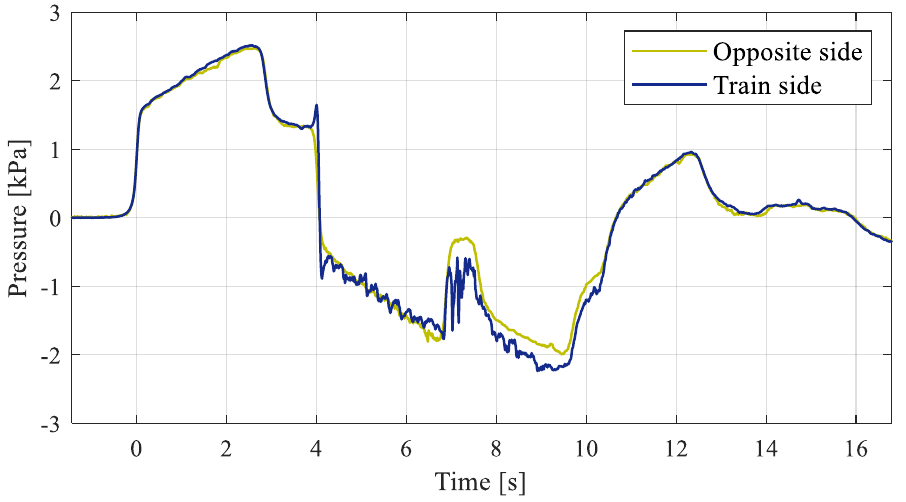
Figure 7. Comparison between the pressures acquired within the tunnel on the train side and on the opposite side.